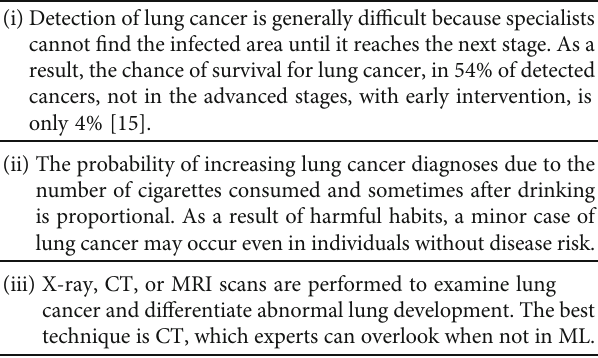
Table 1: Lung cancer: causes and